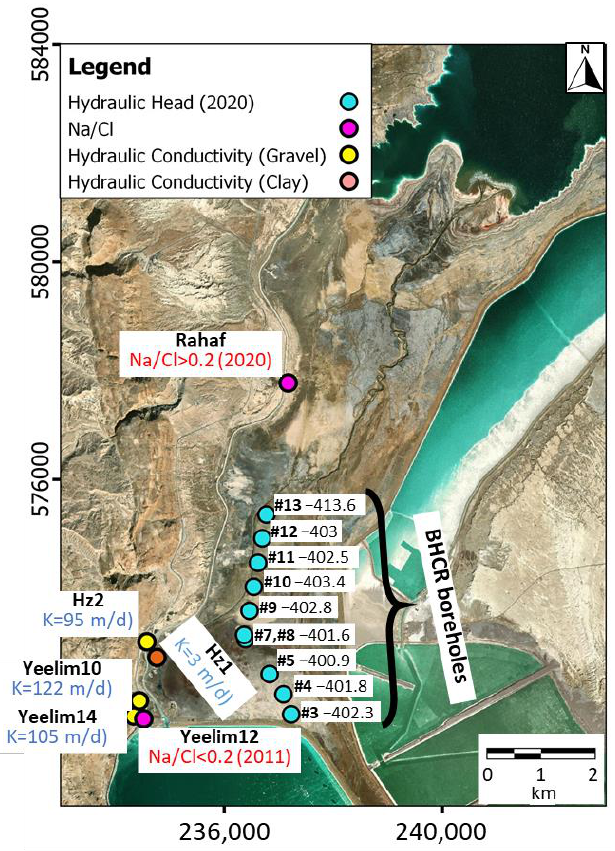
Figure 3. Satellite image of the leakage zone, similar to Figure 1E. Wells from which hydraulic and geochemical parameters were collected are shown.